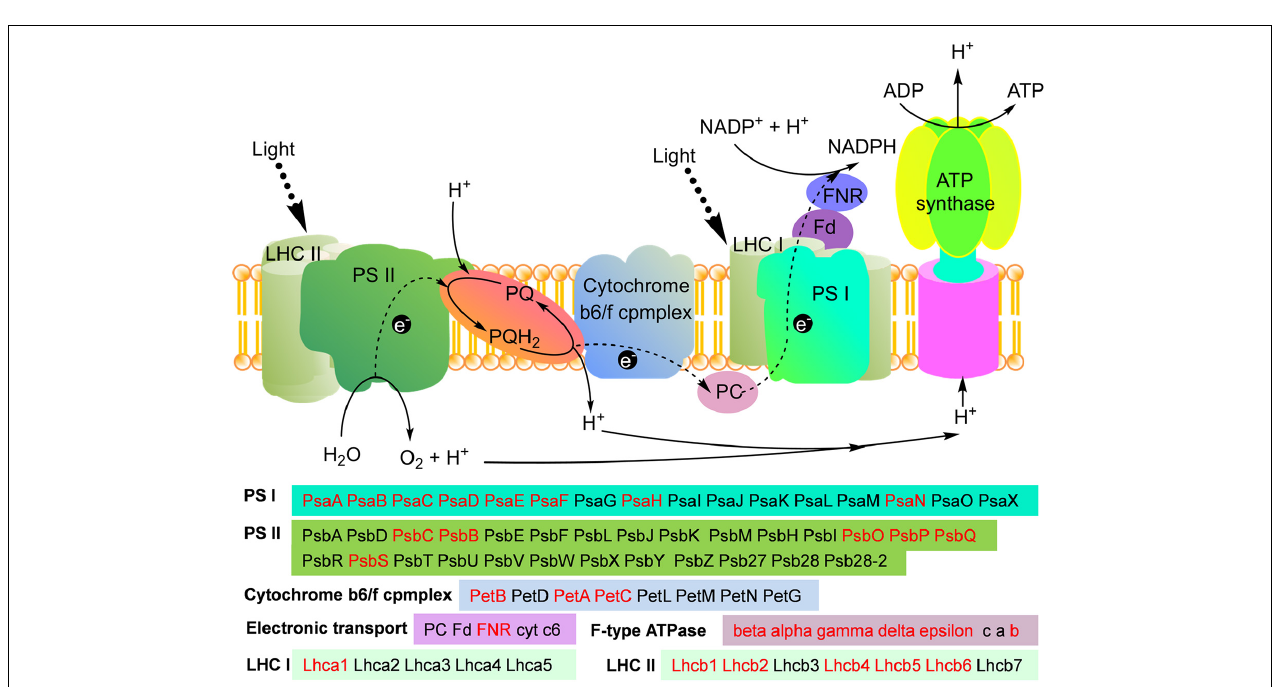
FIGURE 5 | Working scheme of lysine malonylation events associated with in photosynthesis. The identified malonylproteins were marked in